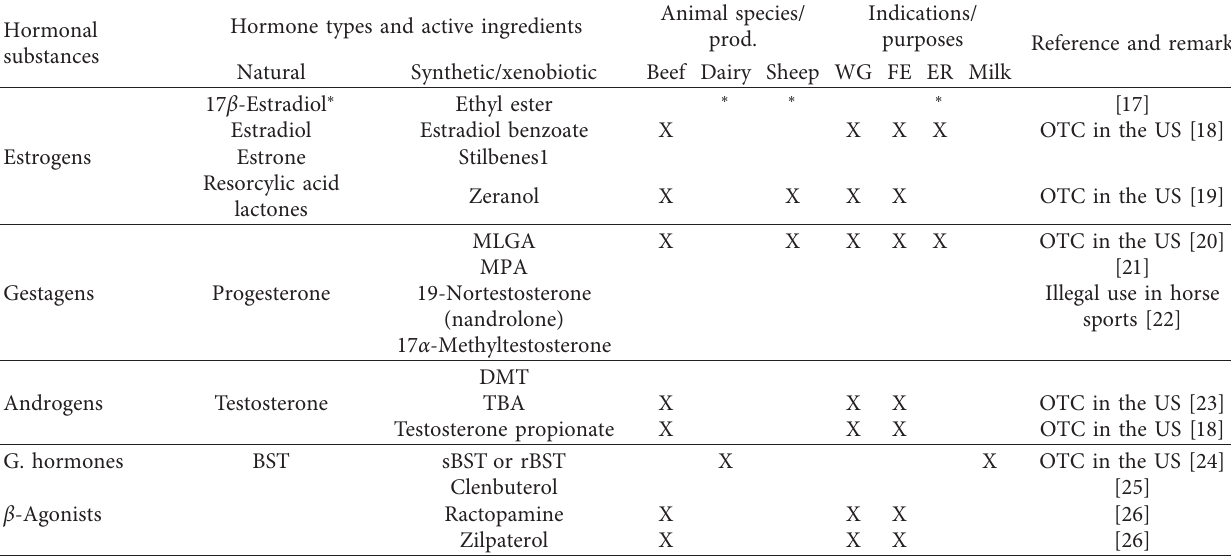
Table 1: Hormones and hormone-like compounds by their type, indications, and approval status. Hormone types and active Hormonal substances